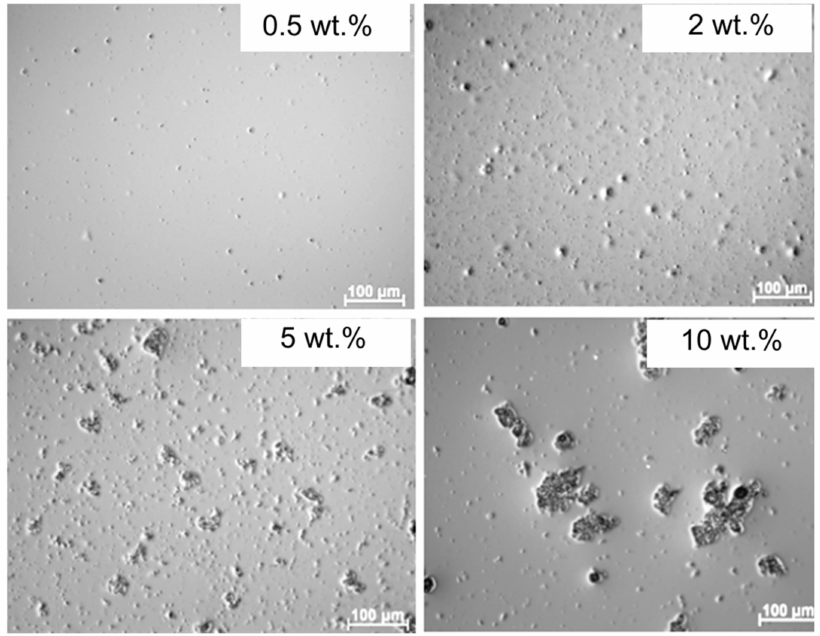
Figure 3. Optical microscopy of CuFe 2 O 4 /Cu 2 O/CuO composite coatings as a function of the NP content.